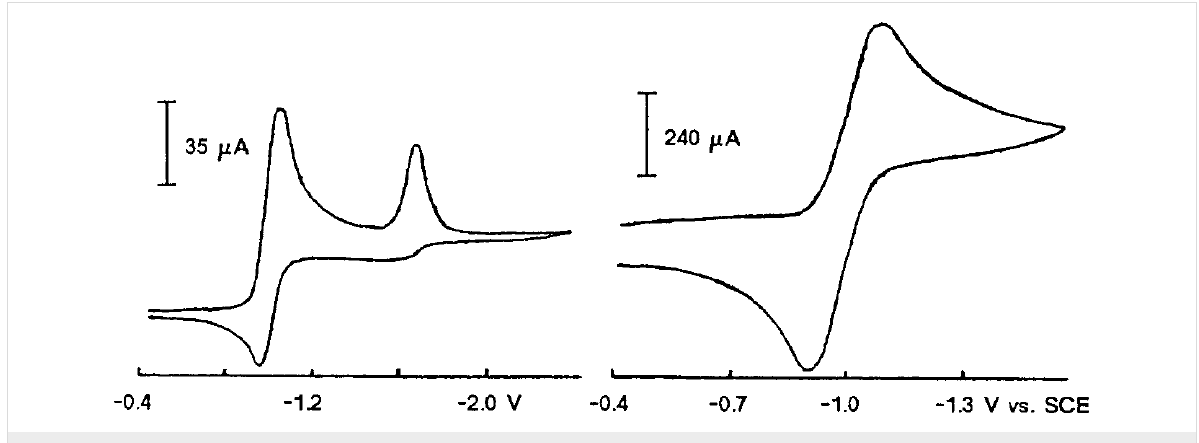
Figure 1: (a) CV of 15 ; v = 0.1 V/s, (b) CV of 15 ; v = 10 V/s.